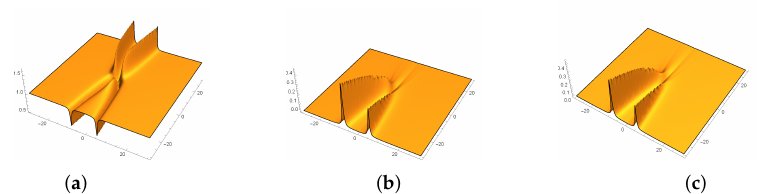
Figure 11. ( a – c ) are the first-order rational soliton solution via Equations (26a)–(26c) with ρ = 1, φ = 0, c 1 ( z ) = 0, c 2 ( z ) = z 2 and γ 1 = 1 + 3 i , respectively.